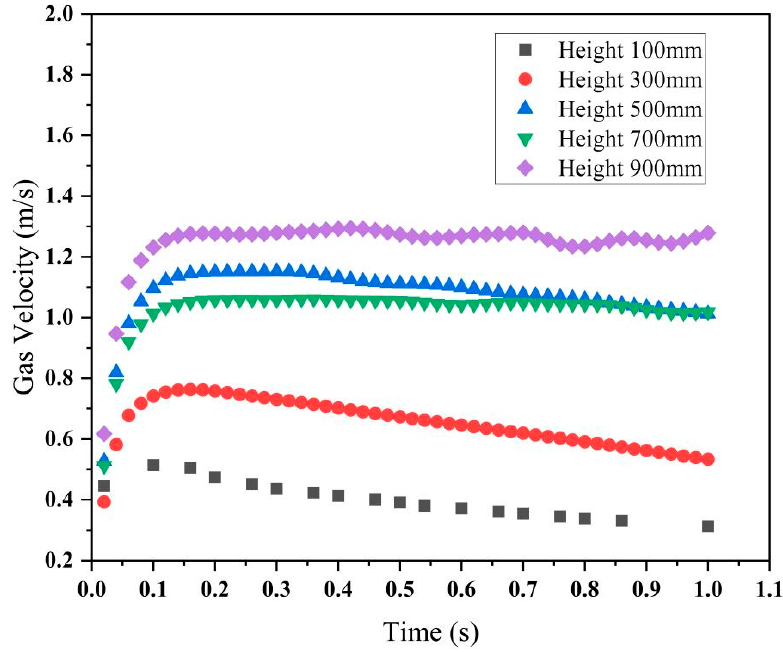
Figure 16. Velocity of a point in a fracture at different fracture heights.